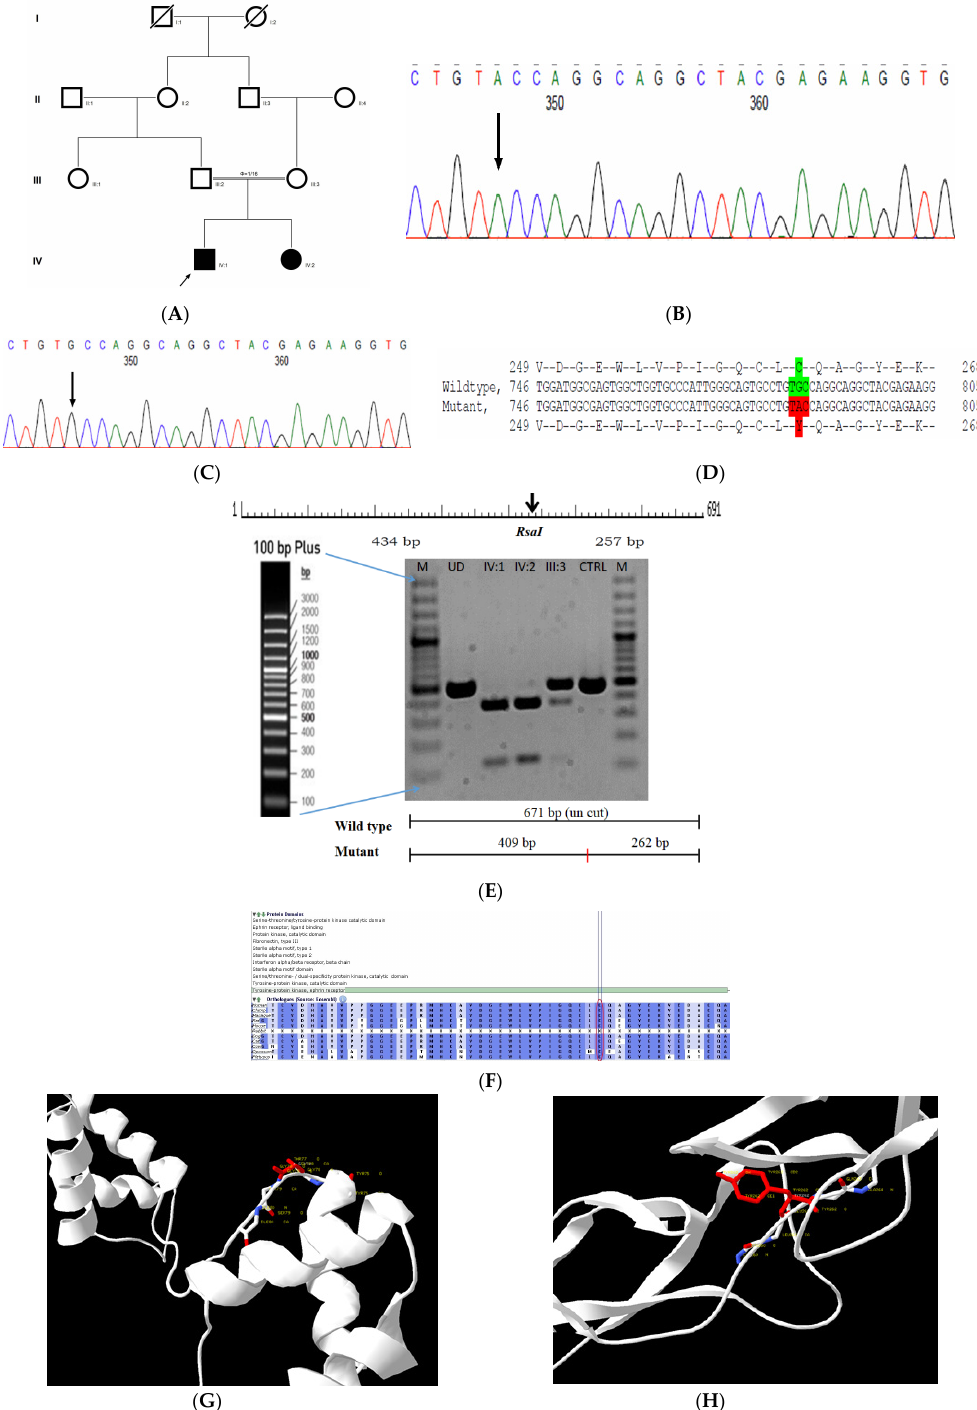
Figure 3. Pedigree of CCE13 ( A ). Partial sequence chromatogram of the proband (( B ), IV:1) and control subject ( C ), EPHA2 exon 3, depicting a homozygous mutation (c.785G > A; p.Cys262Tyr). Mutant and wildtype nucleotide peaks “A” and “G” marked by an arrow. Missense mutation (red) compared with wildtype sequence (green) ( D ). RFLP analysis of the mutation p.C262Y in EPHA2 ( E ), which shows co-segregation of the homozygous mutation among a ff ected family members (IV:1 and IV:2). Una ff ected mother as the carrier (III:3). Control (DKC192) (CTRL) shows no digestion. UD—undigested PCR Product. Amino acid sequence alignment of human EPHA2 and orthologs from other species ( F ), showing conservation of p.C262 (encircled in red). Divergent amino acid residues